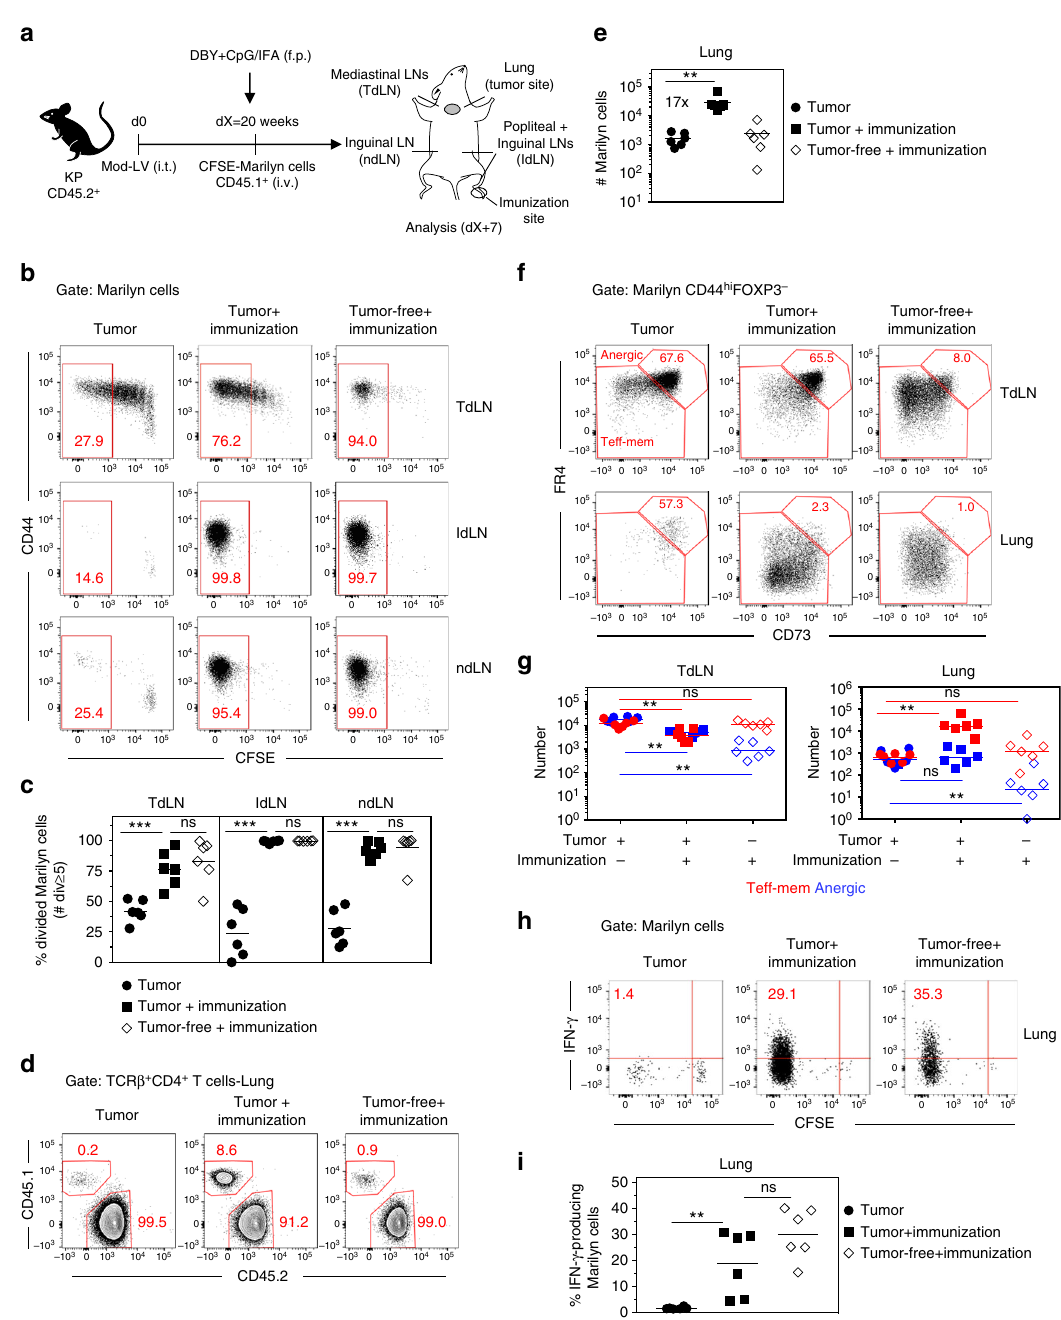
Fig. 9 Priming of tumor Ag-speci fi c naive CD4 + T cells at distant site from the tumor restores their effector functions. a Tumor-bearing mice having received CFSE-labeled naive Marilyn cells were immunized into the f.p. with DBY peptide (200 ng) and CpG (40 μ g) emulsi fi ed in IFA or left untreated. Analysis was performed 7 days later. b Pattern of proliferation of Marilyn cells in the TdLN, lymph nodes draining the Ag injection site (IdLN = popliteal + Inguinal-LNs) and ndLN (non-draining LN = Inguinal) and c quanti fi cation (frequency of ≥ 5 divisions). d Representative plots showing accumulation of Marilyn cells in the lung of immunized tumor-bearing mice and e quanti fi cation (number). f Representative expression of CD73 and FR4 by CD44 hi FOXP3 − Marilyn cells and g quanti fi cation (number of anergic or Teff-mem cells) h , i Frequency of IFN- γ -producing Marilyn cells in the lung. One representative experiment out of two is depicted. ns: non-signi fi cant, **p<0.01, ***p<0.001 Mann – Whitney U